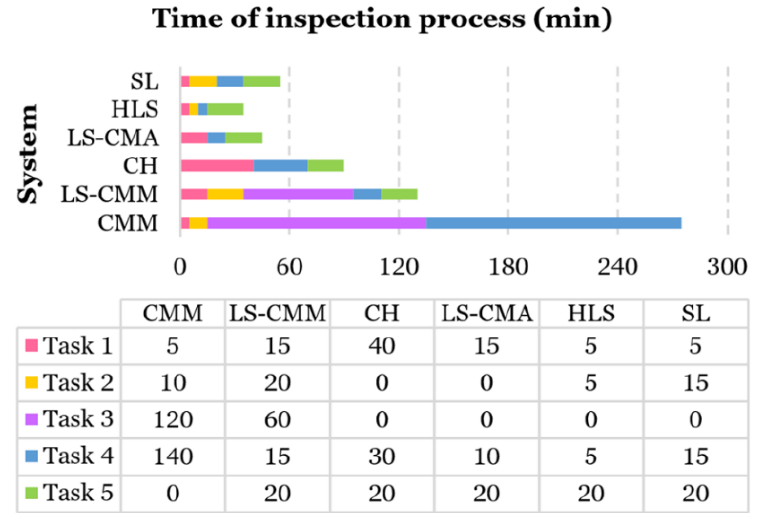
Figure 11. Approximate time spent on each task for each measurement system (contact and optical).